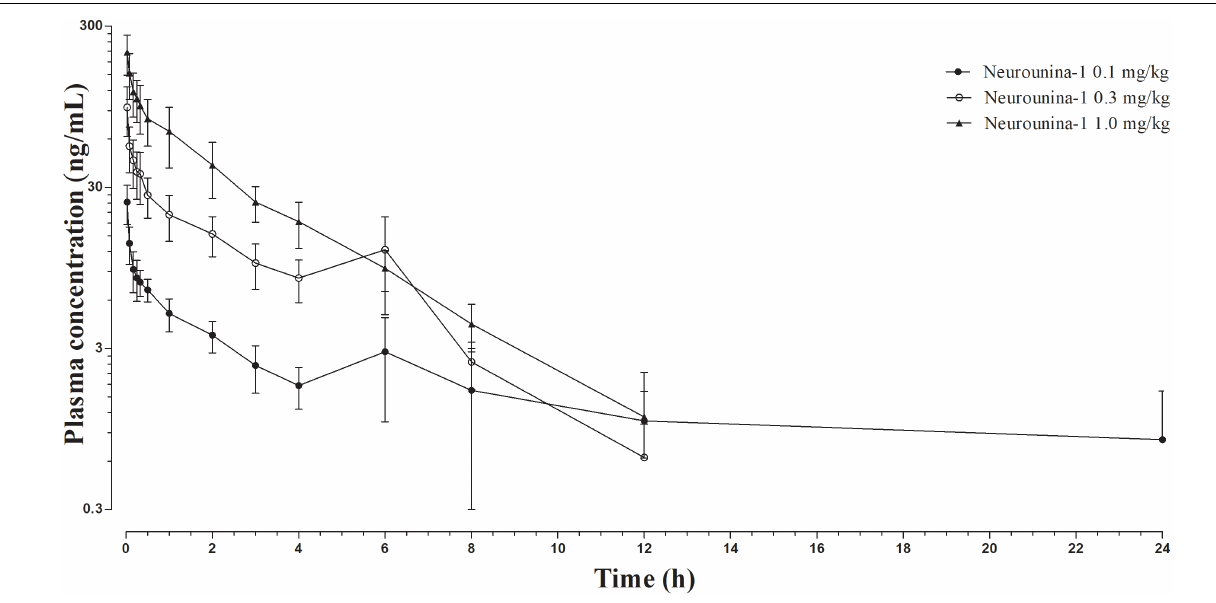
Frontiers in Pharmacology |